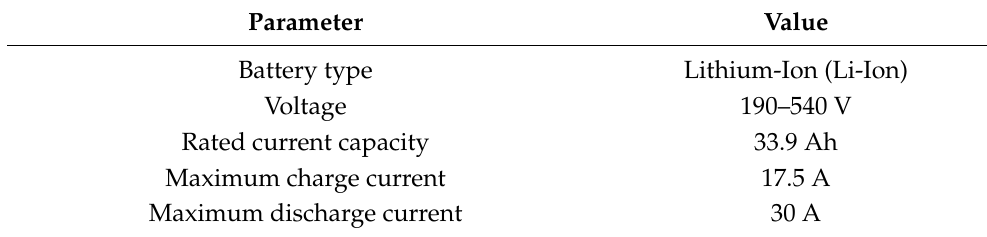
Table 3. Battery Parameters.